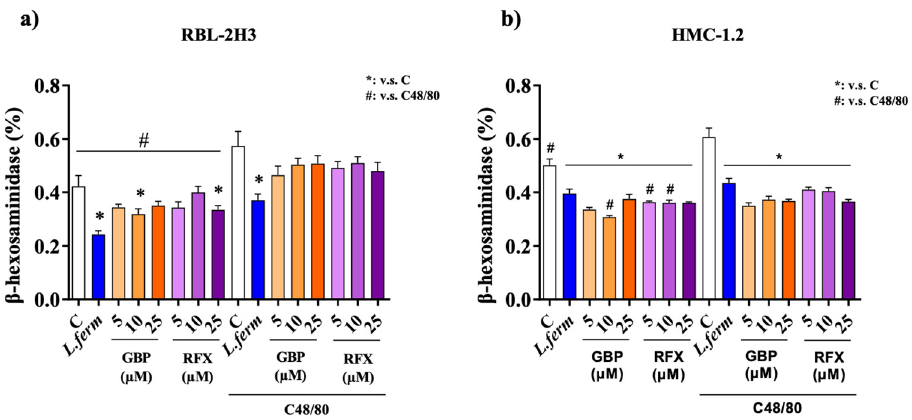
Figure 6. Evaluation of β -hexosaminidase production in RBL-2H3 cells ( a ) and HMC-1.2 cells ( b ). Cell controls (called C) and cells incubated with L. fermentum (1 × 10 9 UFC/mL), Gabapentin (GBP at 5, 10 and 25 µ M) or Rifaximin (RFX at 5, 10 and 25 µ M) and then stimulated with Compound C48/80 or vehicle. Experiment was performed in triplicate. Data are expressed as means ± S.E.M. Groups with * are statistically different ( p < 0.05) from the control group (non-stimulated cells). Groups with # statistically differ ( p < 0.05) from the C48/80 stimulated group.